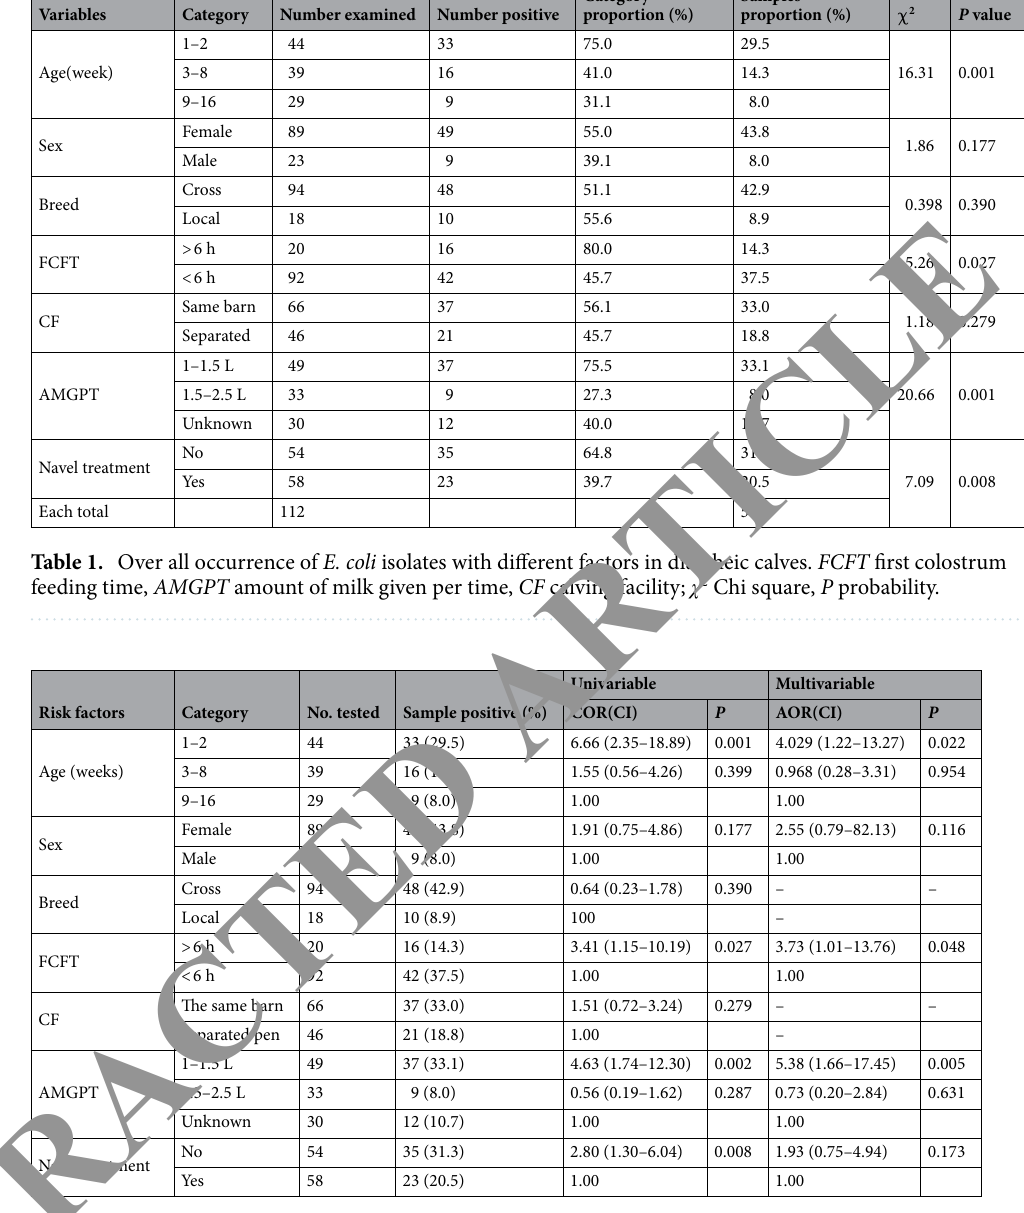
Table 2. Risk factors associated with E. coli isolates in calves by univariable and multivariable logistic regression. COR crude odd ratio, AOR adjusted odd ratio, CF calving facility, AMGPT amount of milk given per time, CI confidence interva, P probability, 1.00 rreference